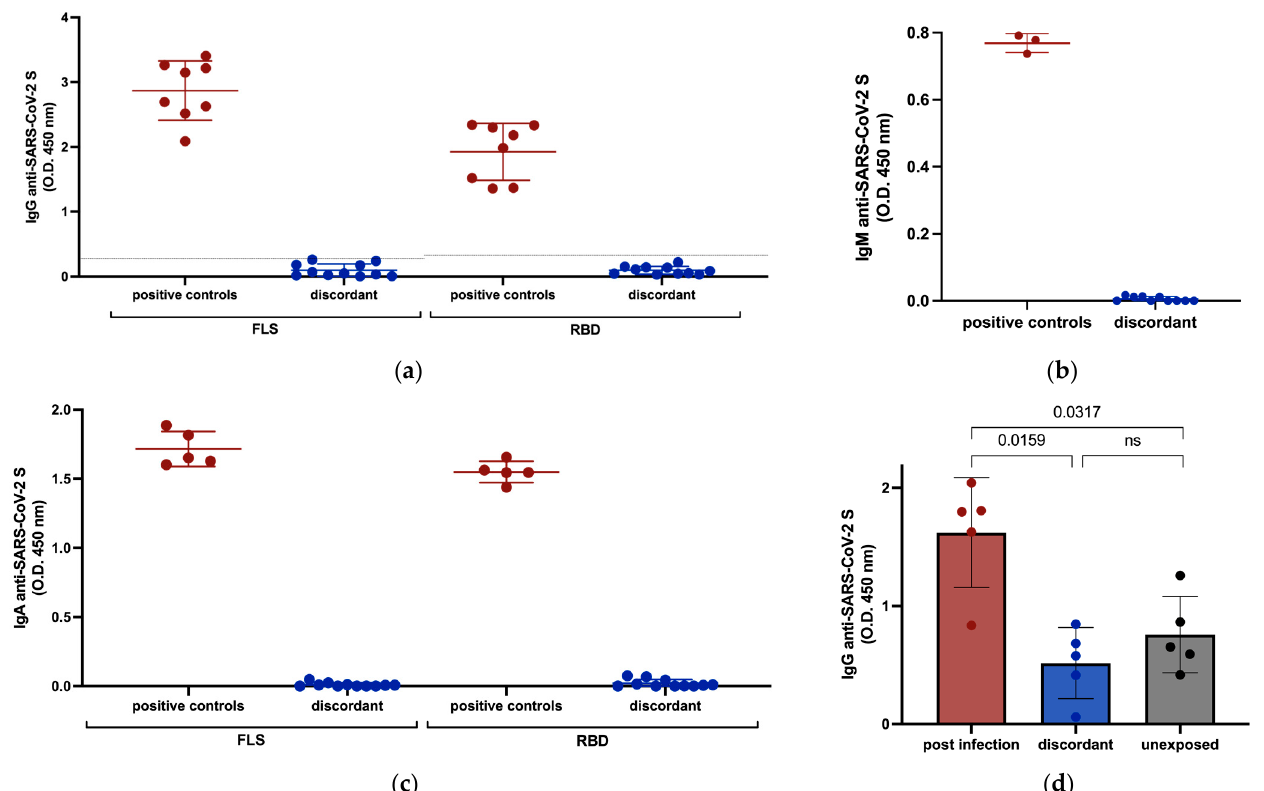
Figure 1. Serological responses of discordant case subjects against SARS-CoV-2 S measured by ELISA. ( a ) IgG antibody responses to SARS-CoV-2 FLS and RBD with plasma samples from previously infected subjects included as positive controls. The horizontal lines represent cut-off values for seropositivity established as 2 SD above the mean OD of control samples collected before October 2019. ( b ) IgM antibody response of discordant subjects with plasma samples from previously infected subjects included as positive controls against SARS-CoV-2 FLS. ( c ) IgA antibody response of discordant subjects with plasma samples from previously infected subjects included as positive controls against SARS-CoV-2 FLS and RBD. ( d ) Comparison of IgG antibody responses against SARS-CoV-2 FLS protein following one dose of BNT162b2 mRNA vaccination between previously infected, non-exposed, and 5 discordant individuals (1185, 1340, 1383, 1418, 1637) for whom post-vaccine 1 samples were available. Red and blue shading of dots and bars represents positive controls and discordant case subjects respectively. Black dots and the gray shaded bar represent previously unexposed subjects. The probability of a significant difference between groups was calculated using the Mann–Whitney test, with p values or ns (not significant) shown above lines spanning the groups compared.